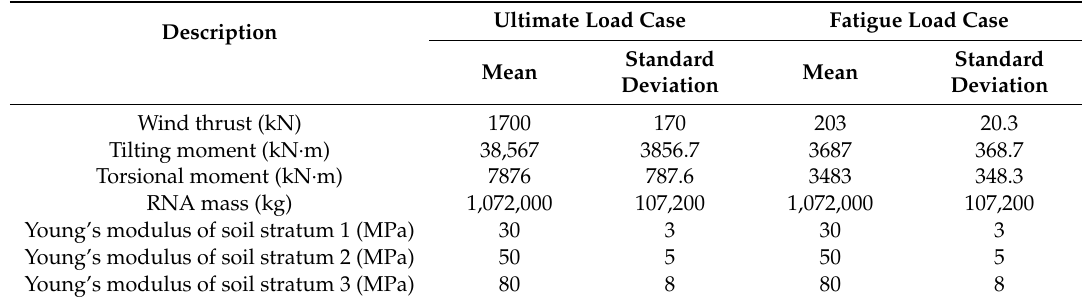
Table 9. Characteristics of design variables.